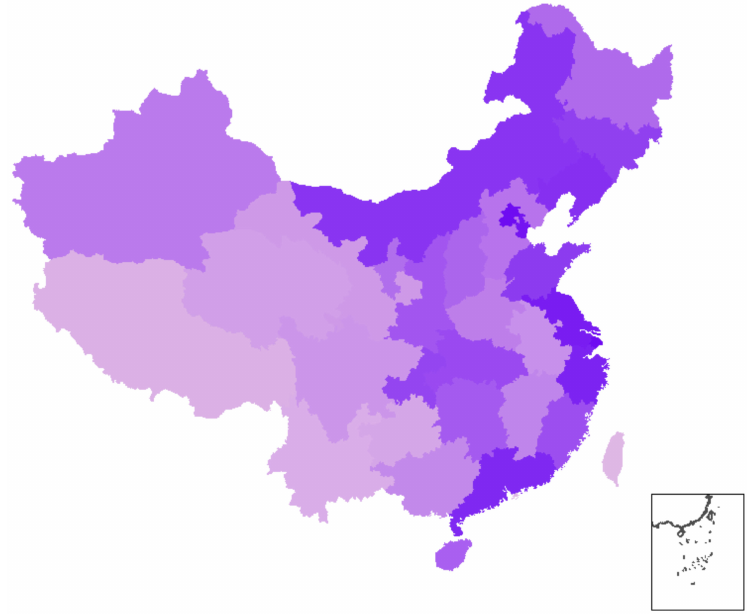
Figure 1. HDI ranking of Chinese provinces in